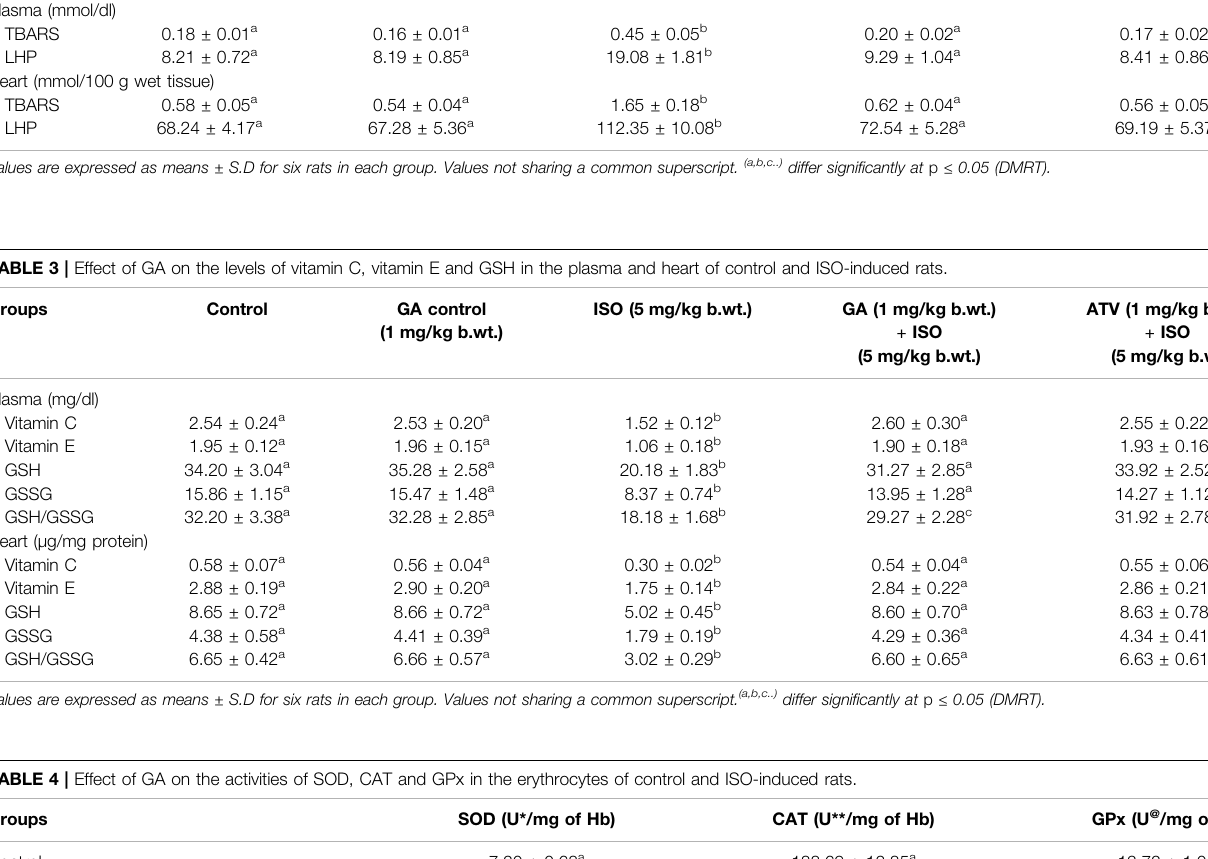
TABLE 2 | Effect of GA on the levels of TBARS and LHP in the plasma and heart of control and ISO-induced rats. Groups Control GA control ISO (5 mg/kg b.wt.) (1 mg/kg b.wt.)